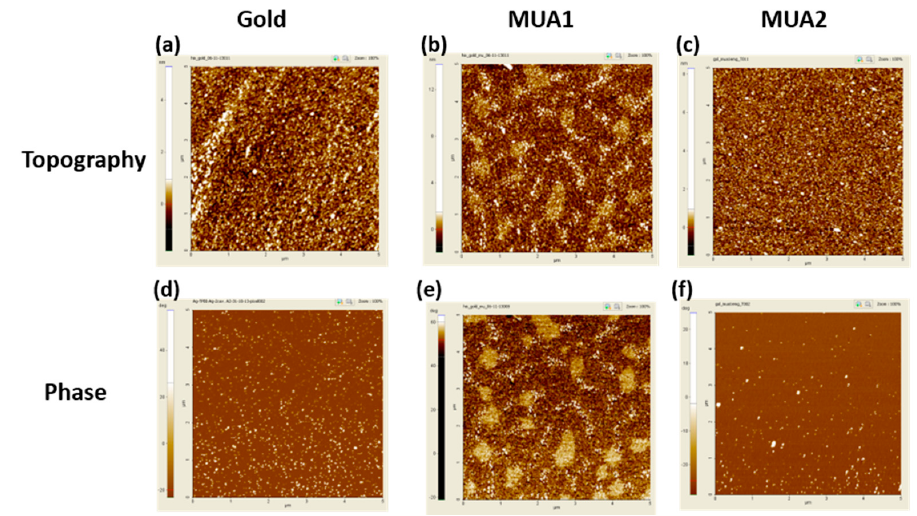
Figure 4. Atomic Force Microscope (AFM) topographic ( a ), ( b ), and ( c ) and phase ( d ), ( e ), and ( f ) images of gold surface on silicon chips ( a ), ( d ), incubated over night with MUA (MUA1) ( b ), ( e ) and coated with gold and incubated over weekend with MUA (MUA2) ( c ), ( f ). The scan area is 5 × 5 μ m.